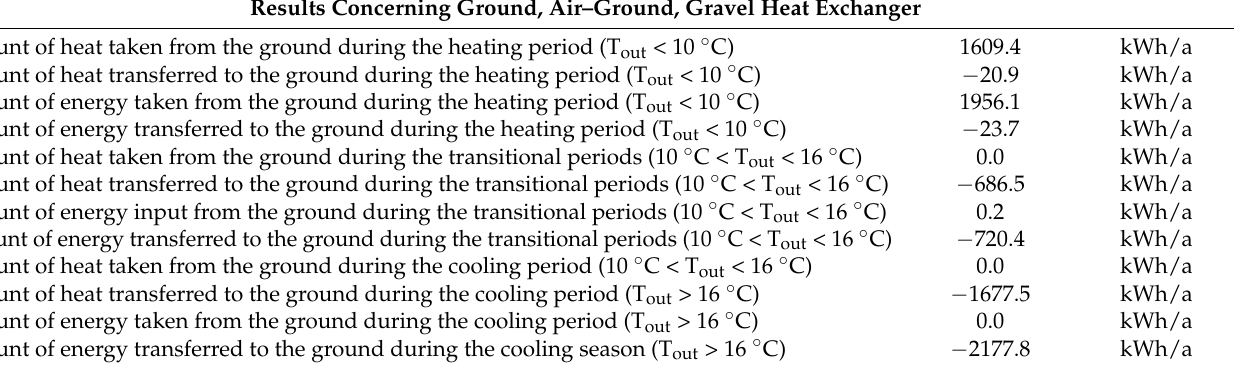
Table 1. Amount of heat and energy taken/given from the ground through a GGAHE.